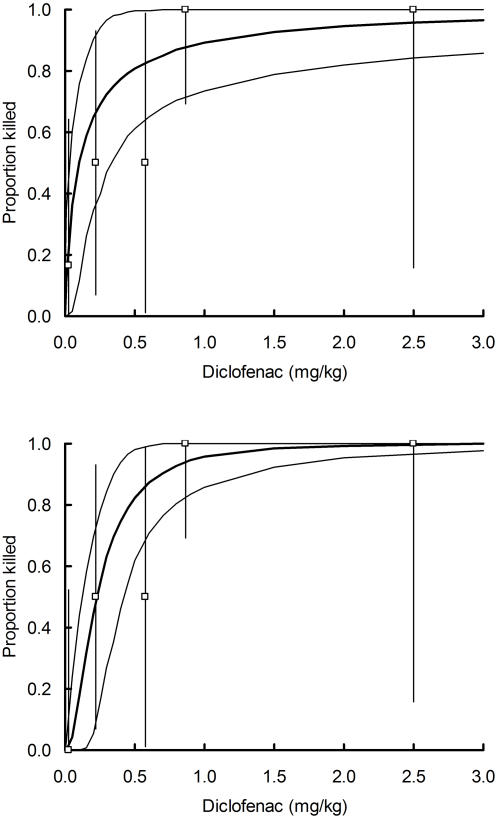
Relationship between the proportion of oriental white-backed vultures treated experimentally with diclofenac that died and the dose of diclofenac administered per unit vulture body weight.Plotted points are proportions killed for each of five bins of dose, with 95% exact binomial confidence limits (vertical lines). Bins include 6, 4, 2, 10, and 2 birds respectively (ranked from lowest to highest dose). The thick curve is the fitted probit model relating mortality rate to log dose. Thin curves show the envelope enclosing the central 9,500 of 10,000 Monte Carlo replicate values. The upper panel shows results of analysis of all data. The lower panel excludes the datum for an outlier (vulture Gb11) from the lowest dose bin, which died even though it apparently received an extremely low dose of diclofenac. Data are from Table 2 of Oaks et al.
[5].